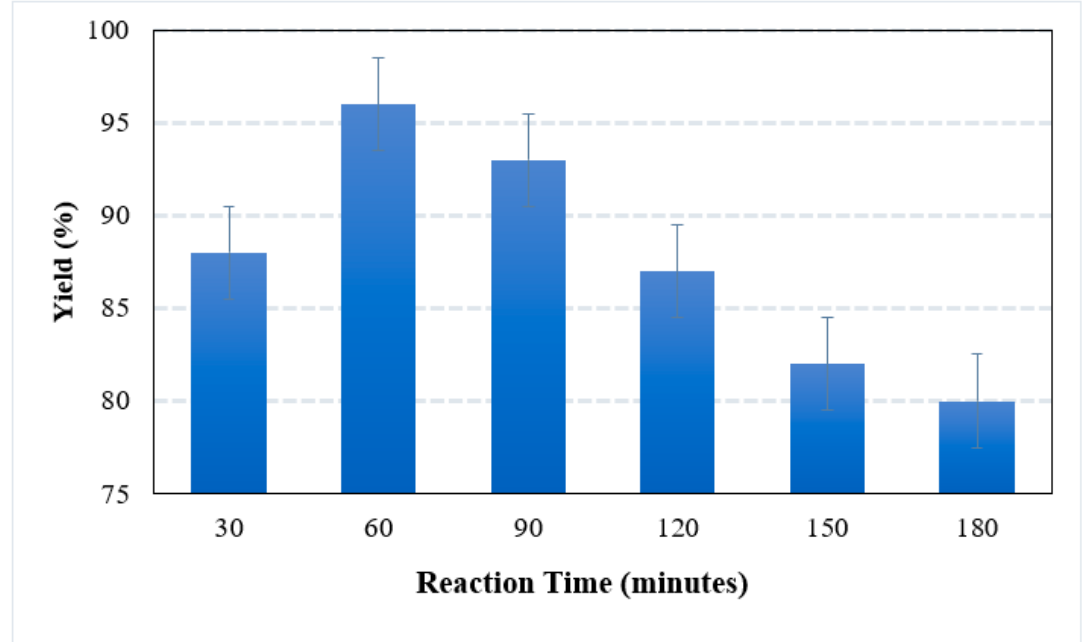
Figure 9. Effect of reaction time on biodiesel production.